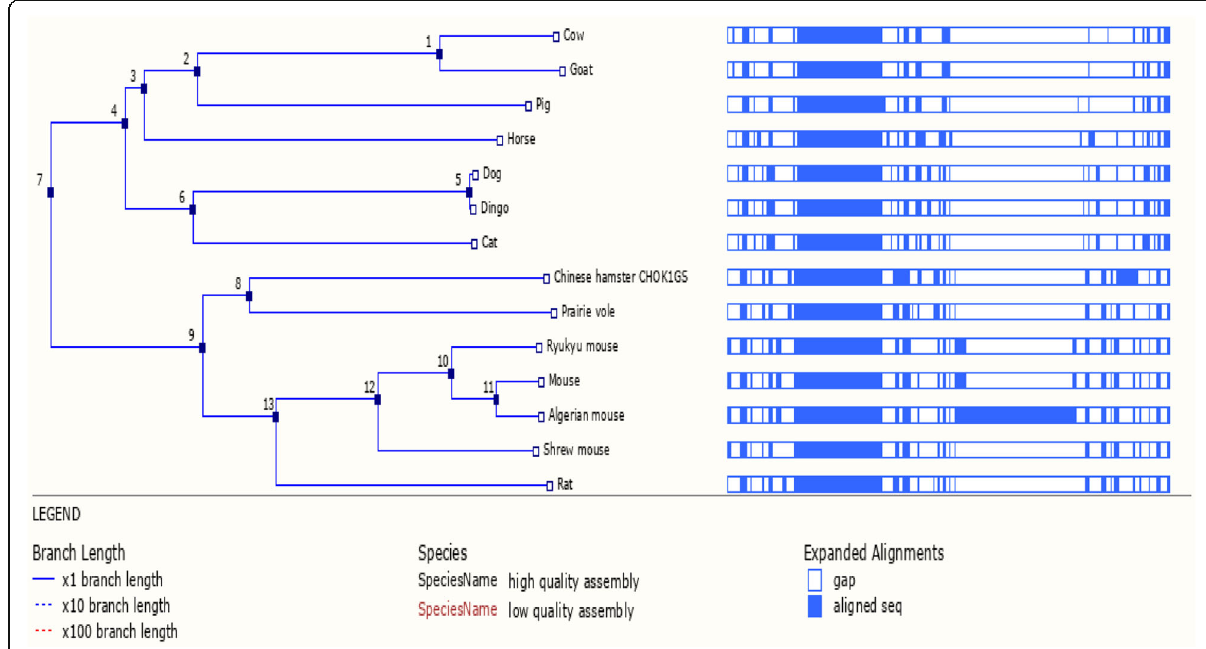
Fig. 4 MC1R gene genomic sequence alignment in different vertebrates